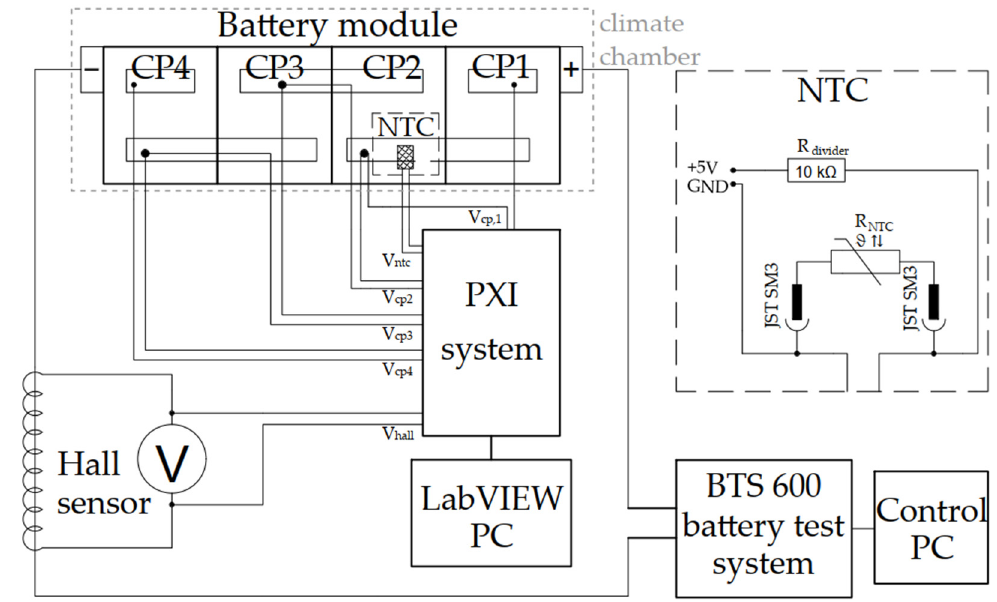
Figure 2. Schematic representation of the experimental setup for the testing procedure.